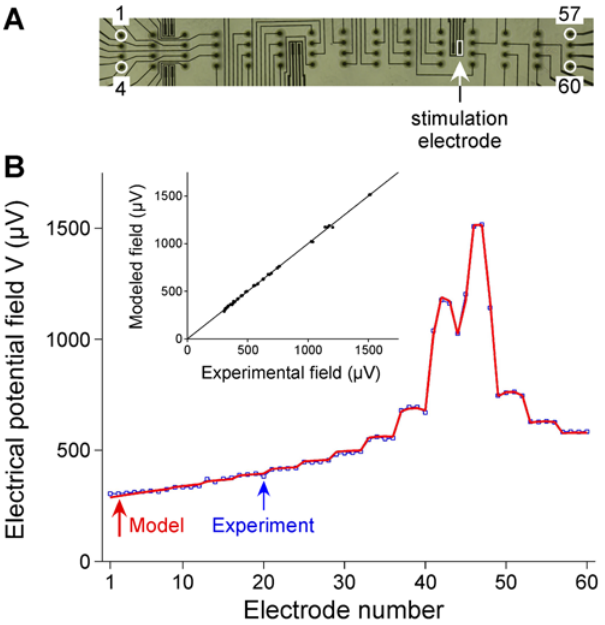
Figure 4. Validation of the extracellular potential field modeling using Robin boundary conditions. A : Microphotograph of the microelectrode array, with the 4 6 15 recording electrodes numbered from 1 to 60 (from top left to bottom right). Current- controlled monopolar stimulations were applied in a Ringer solution between the stimulation electrode (indicated by an arrow) and the external ground electrode. B : The electrical potential field recorded experimentally (square symbols) was modeled (red curve) using the finite element model (described in Figure 1.B) equipped with Robin BCs on the conductive electrodes. The surface conductances of the stimulation and ground electrodes ( g stim and g ground ) were estimated to optimize the fit between modeled and experimental fields. The linear regression between the modeled and the experimental fields is shown in the inset (R 2 =0.999, p ,